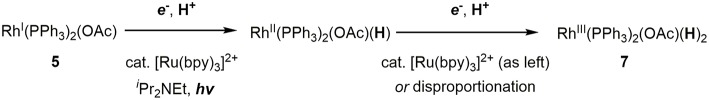
Proposed mechanism for the formation of the Rh(III) dihydride complex.